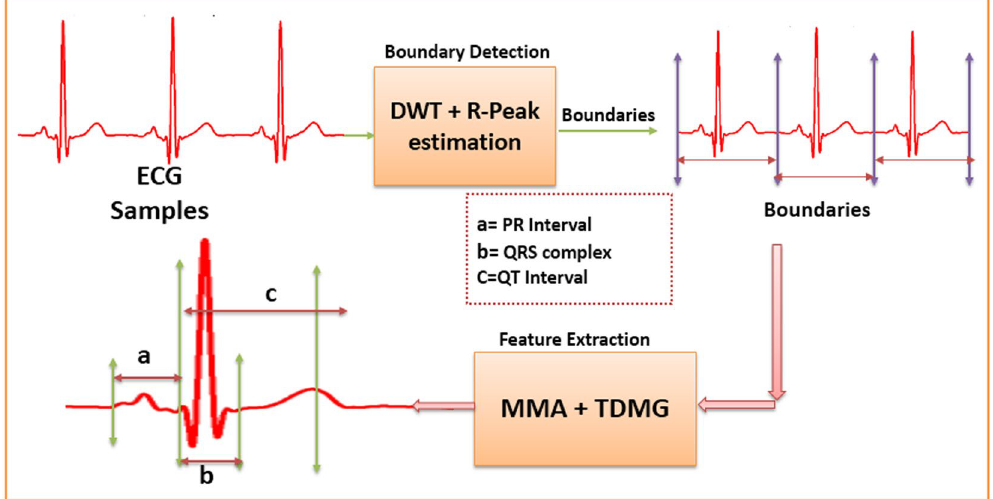
Figure 11. Extraction of boundaries and localized features of continuous ECG signal.